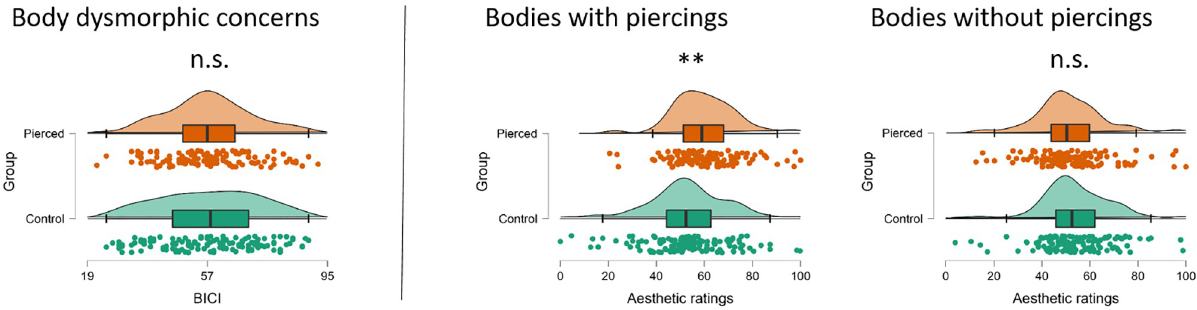
Fig 3. Raincloud plots of BICI scores (left panel) and aesthetic ratings of bodies with and without navel piercings (right two panels) in participants with (orange) and without (turquoise) navel piercings. Each circle represents one participant, n.s. denotes a non-significant group difference, �� denotes p <